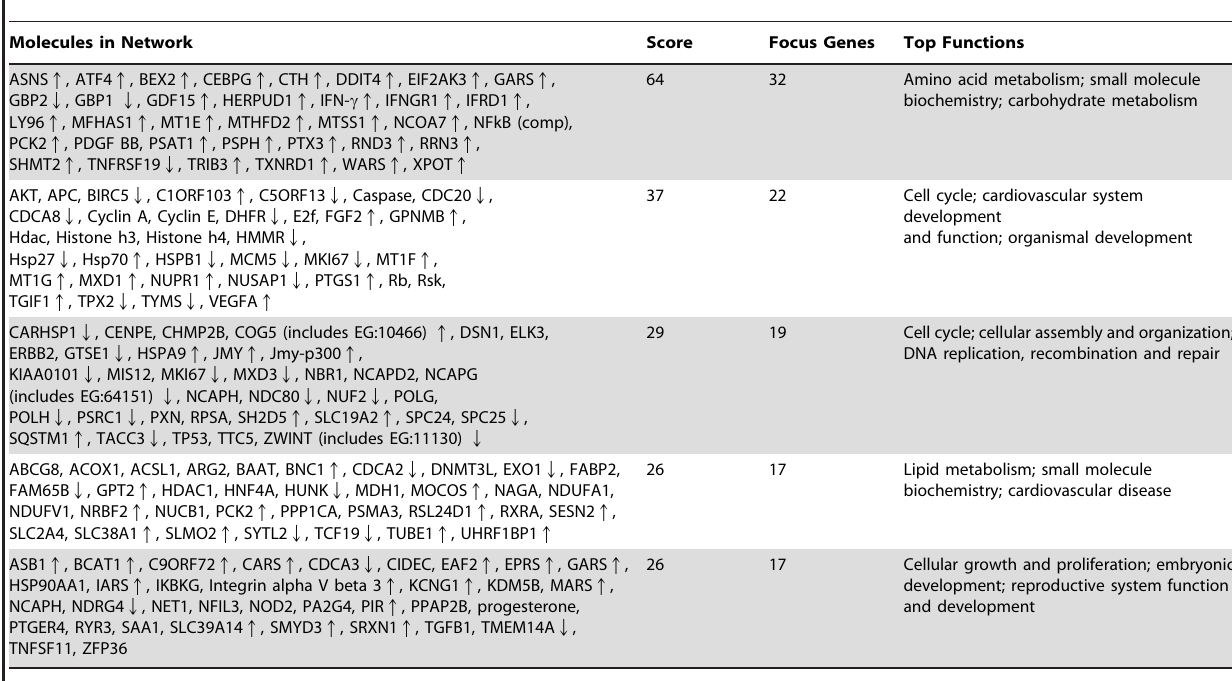
Table 4. Selected genetic networks with high scores ( . 26) in Normal Control vs Normal Rottlerin-exposed human dermal fibroblasts.